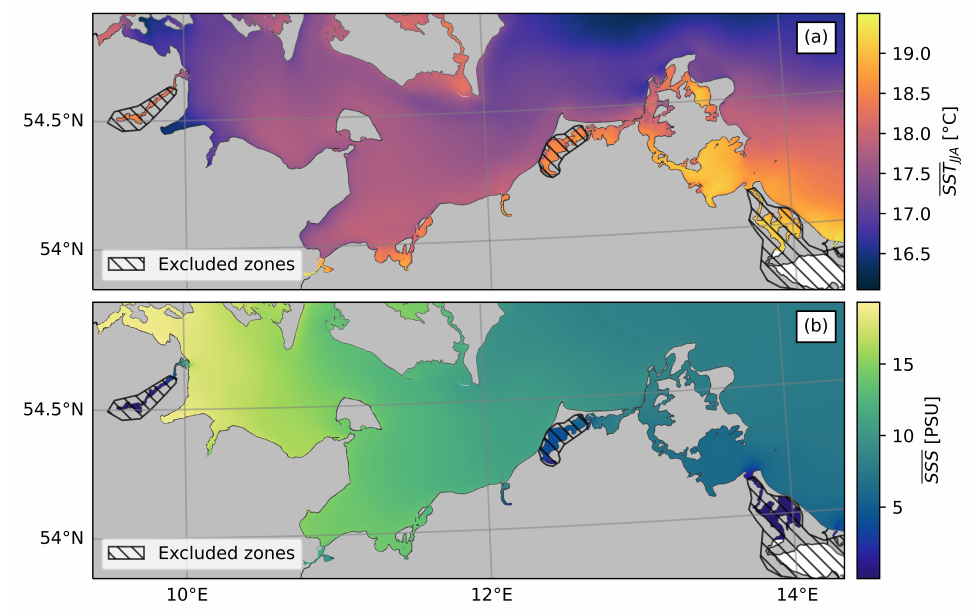
Figure 4. Results of the GETM realisation. ( a ) Average SST in summer months (JJA) in the study period. ( b ) Average SSS in the study period. Dashed areas show regions with unreliable SSS results, which were excluded in the following